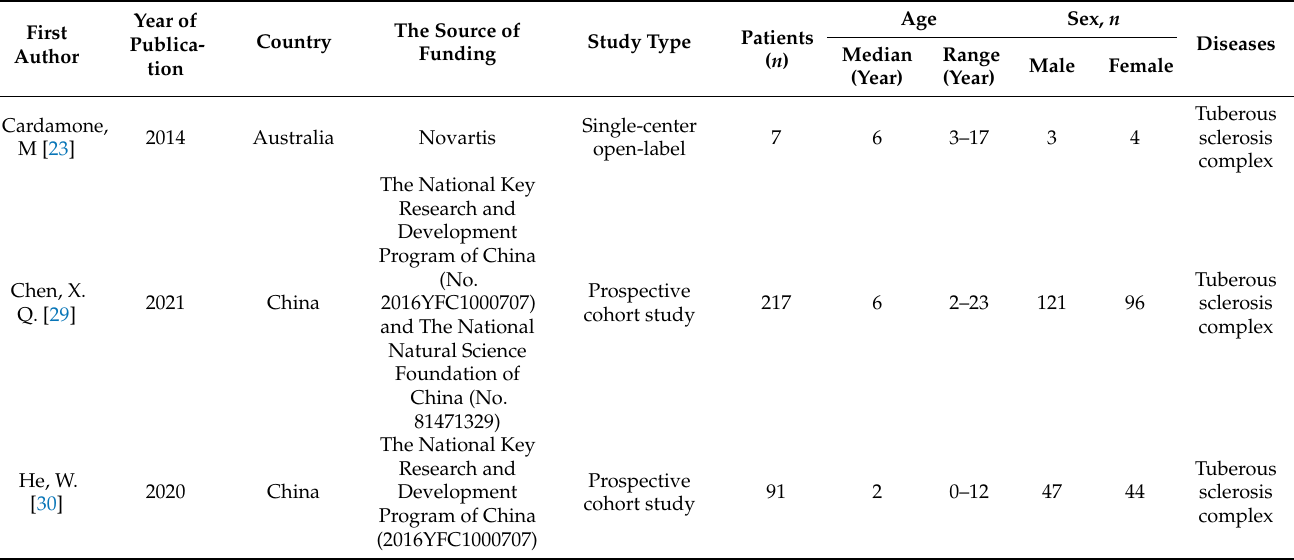
Table 1. List of studies identified and selected through database searches: demographic character- istics.